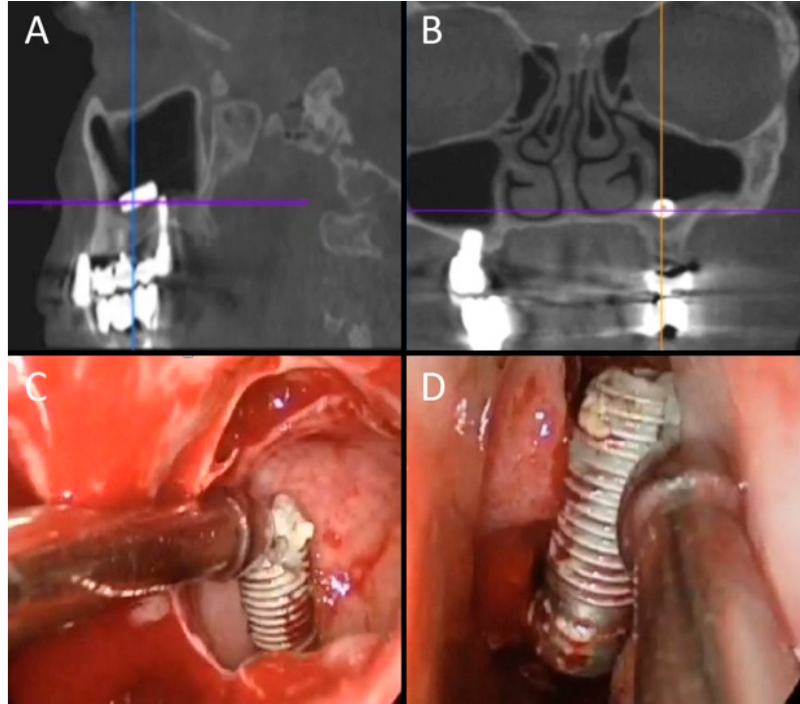
Figure 4. Female patient, 58 years old, who had undergone dental implant surgery several years earlier. CT performed for sinus pain documented migration into the left maxillary sinus (( A ): sagittal scan; ( B ): coronal scan). An endoscopic surgical approach achieved removal of the foreign body (( C ) and ( D )).